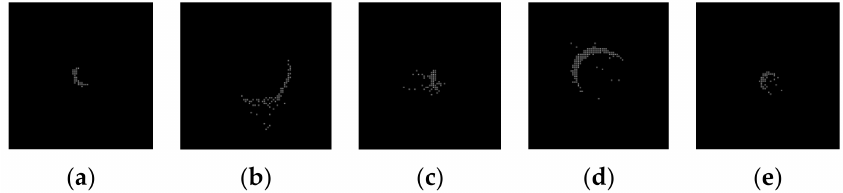
Figure 6. Binary images of five slices of plot 1 and 2 in single-scan mode with height of 1.2–1.35 m, gray scale threshold of 1. ( a ) Tree 2; ( b ) Tree 3; ( c ) Tree 7; ( d ) Tree 11; ( e ) Tree 21.